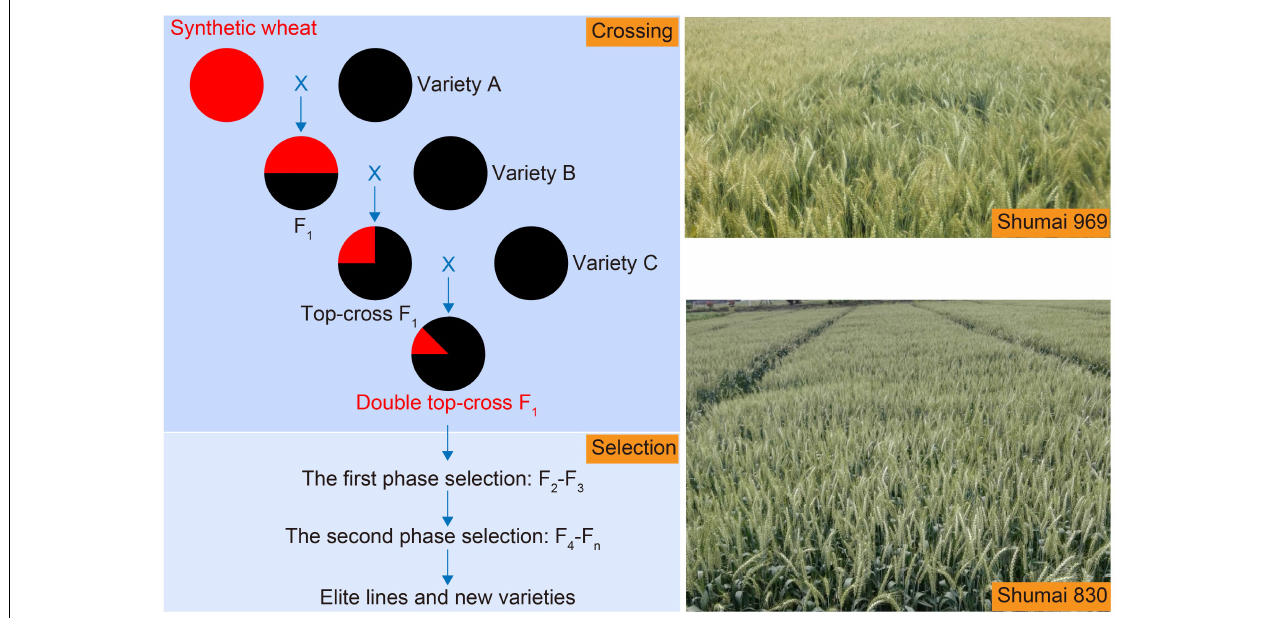
FIGURE 3 | The double top-cross (DTC) and two phase selection (2PS) strategies deployed to manage introgression into elite germplasm from an SHW. The DTC populations retain on average 12.5% of the nuclear genome of the SHW parent. The aim of the first selection phase, carried out in the F 2 and F 3 generations, is to eliminate serious agronomic defects, while that of the second phase (applied from the F 4 generation onward) is to improve yield. Shumai 969 and Shumai 830 were both bred using this strategy.